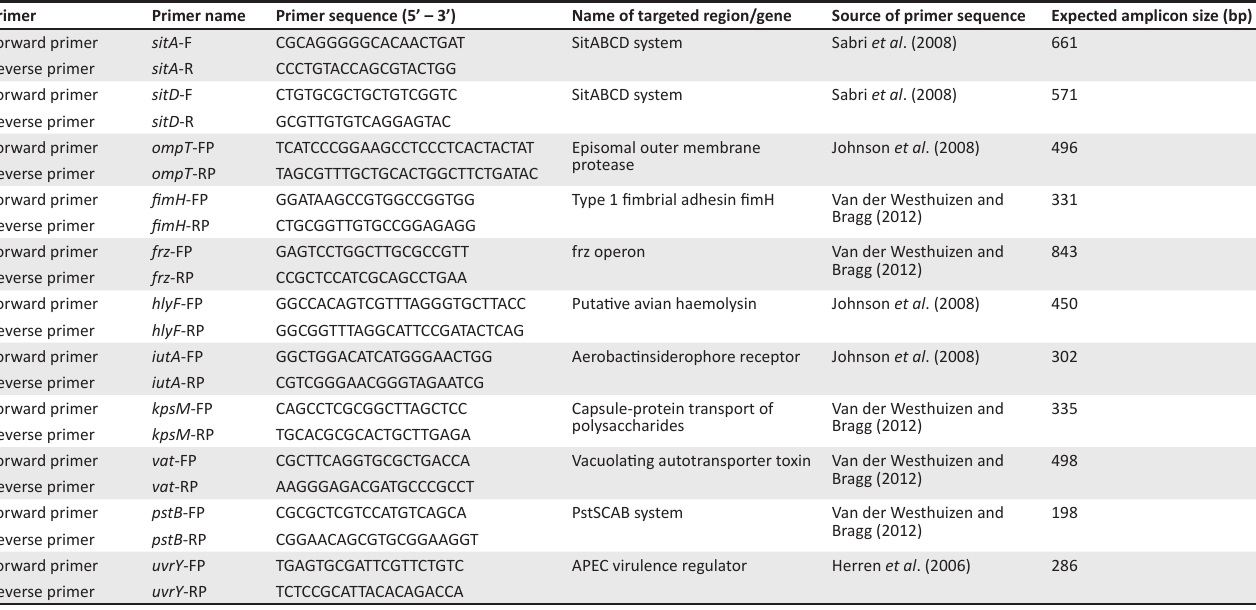
TABLE A1: Primers used for amplifying regions in avian pathogenic Escherichia coli virulence